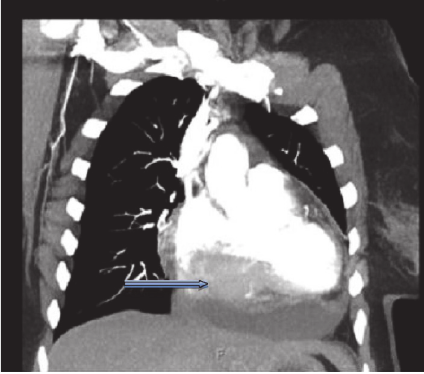
Figure 1: Large right cardiac mass (arrow) on CT angiography.